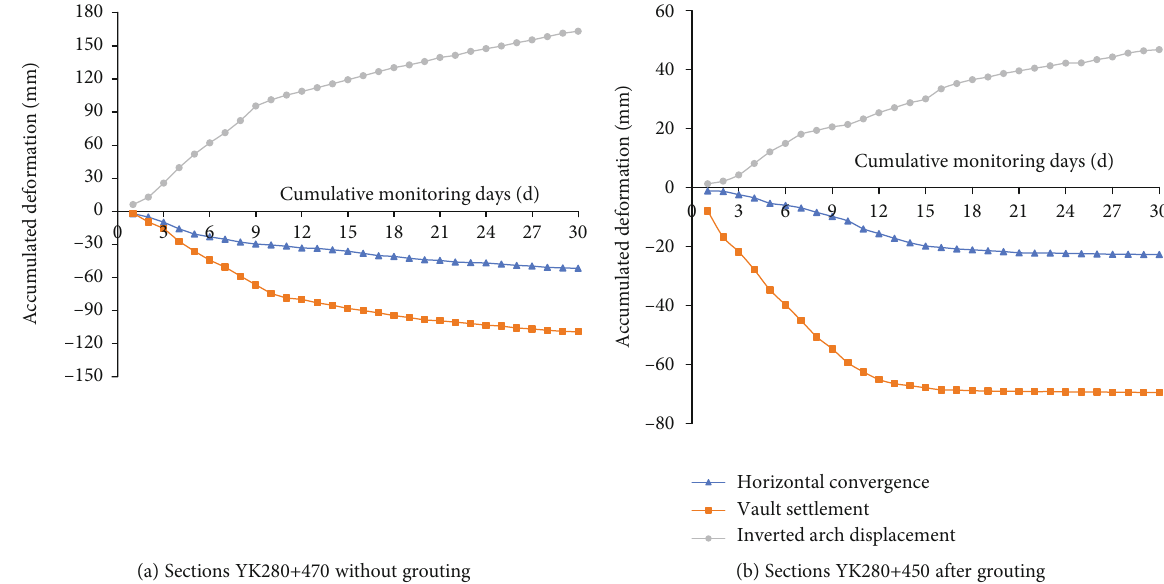
Figure 12: Deformation aging diagram of surrounding rock of adjacent sections before and after